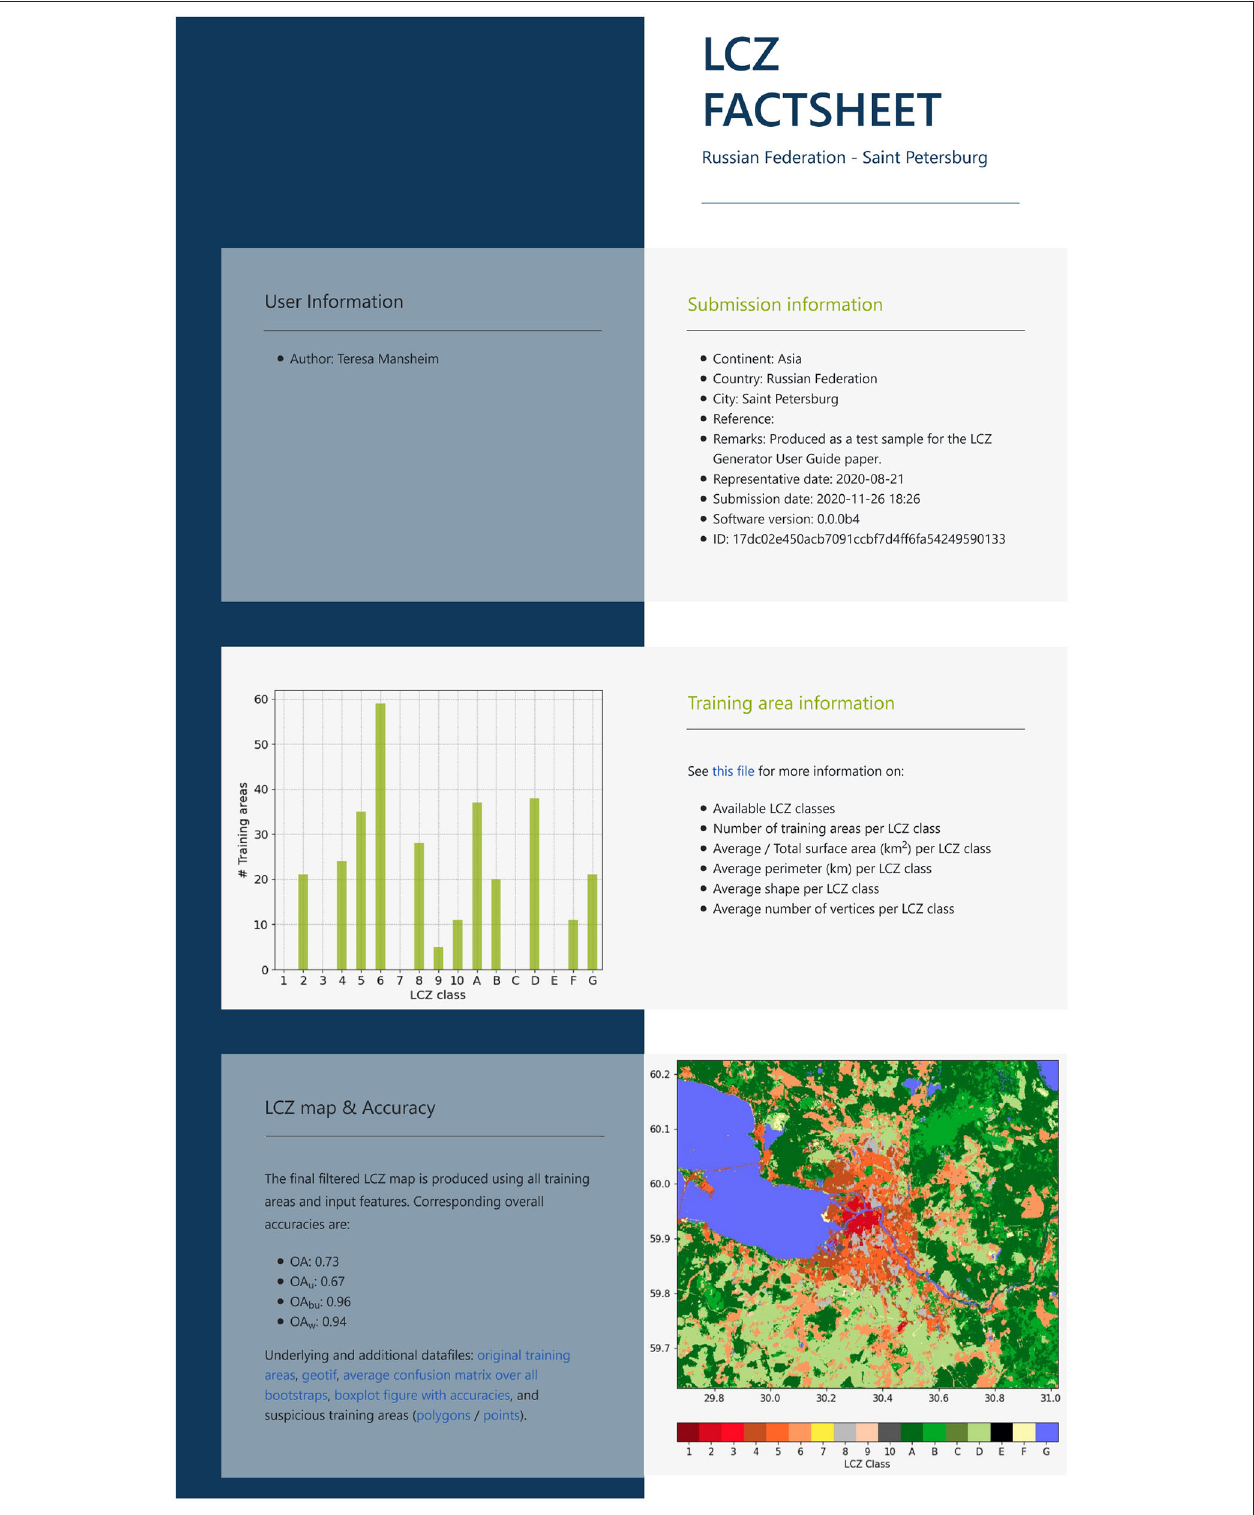
FIGURE 3 | Factsheet example for Saint Petersburg. Note that in reality, the factsheet also contains a “Terms of Service” and “Attribution” section (see section 2.5.4). These sections are omitted here for clarity.